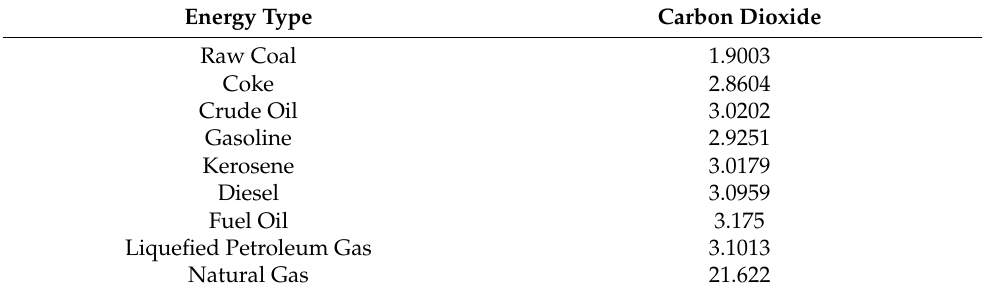
Table 1. Energy Conversion Factor.